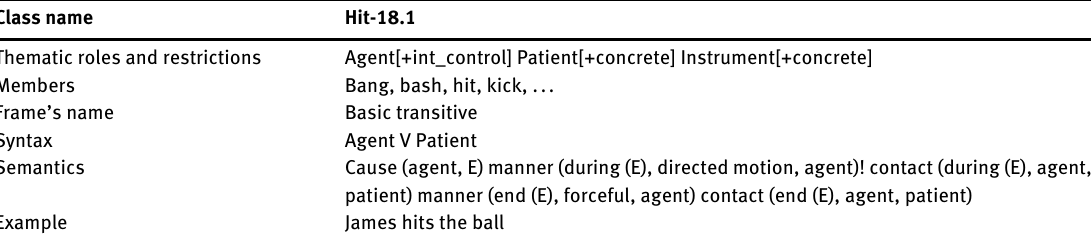
Table 2: Simplified VN Entry for the Hit-18.1